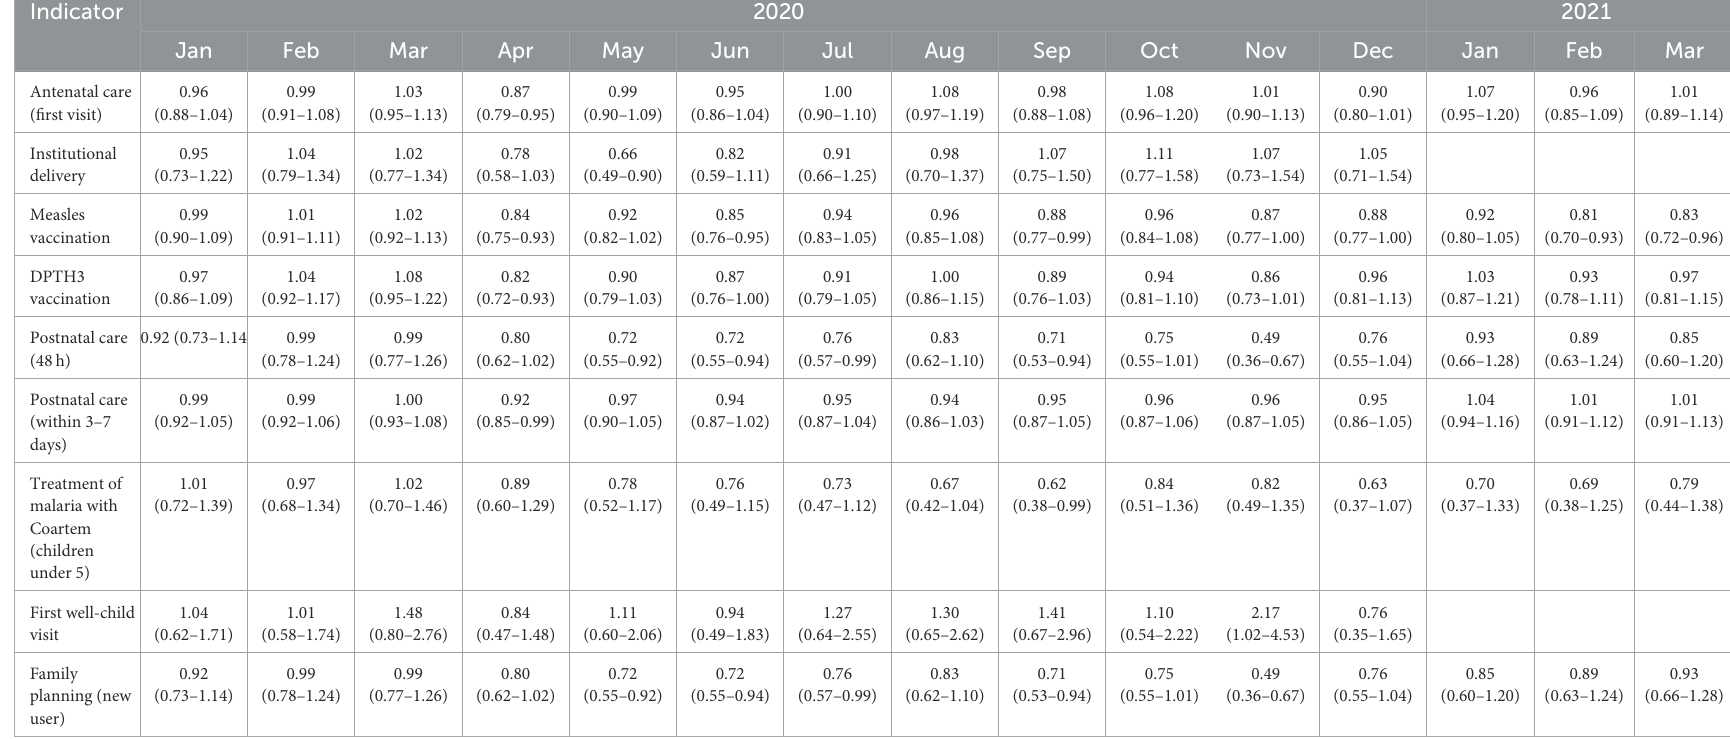
TABLE 5 National-level relative reduction in service counts by indicator and month, 2020 and first quarter of 2021.